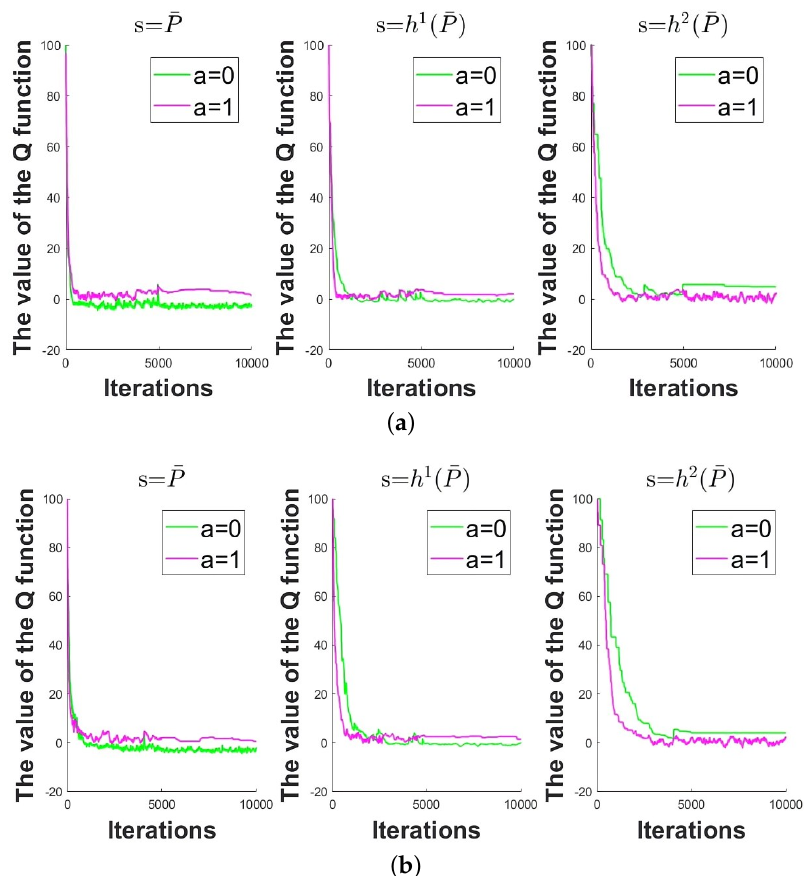
Figure 6. The convergence process of the state-action value Q -function in each state from the perspective of sensor. ( a ) The framework of Q -learning; ( b ) The framework of SARSA.